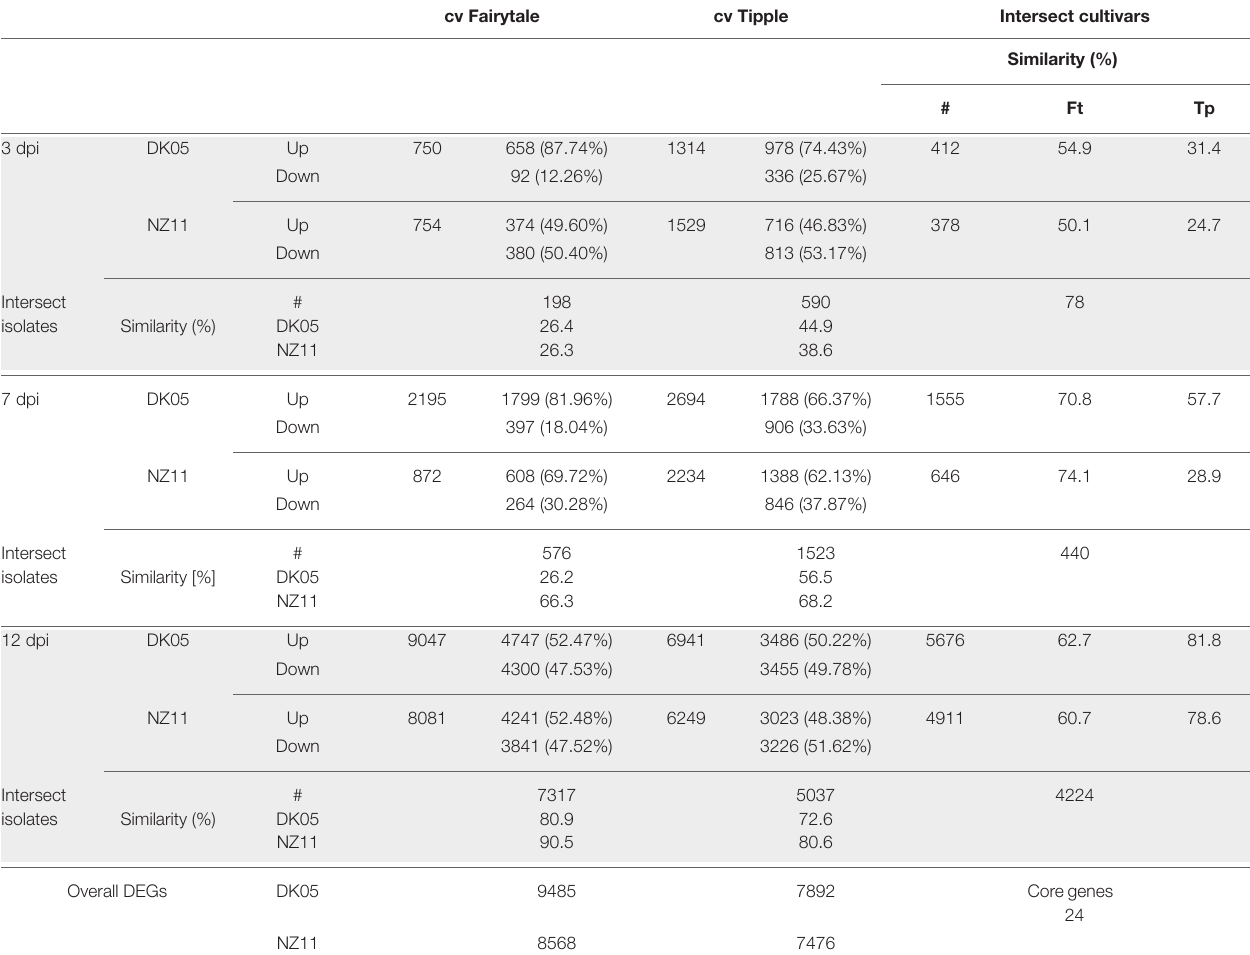
TABLE 1 | Differentially expressed gene number in different treatments and time points.